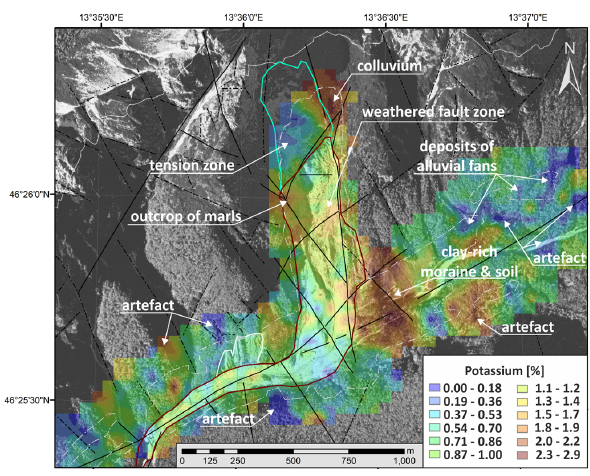
Fig. 6. Gamma ray survey: a map of Potassium combined with the fault and joint pattern (black full and dot-and-dashed lines), area of reliable data (light grey dot-and-dashed line) and the geological interpretation (Source of data: Geological Survey of Austria and Google